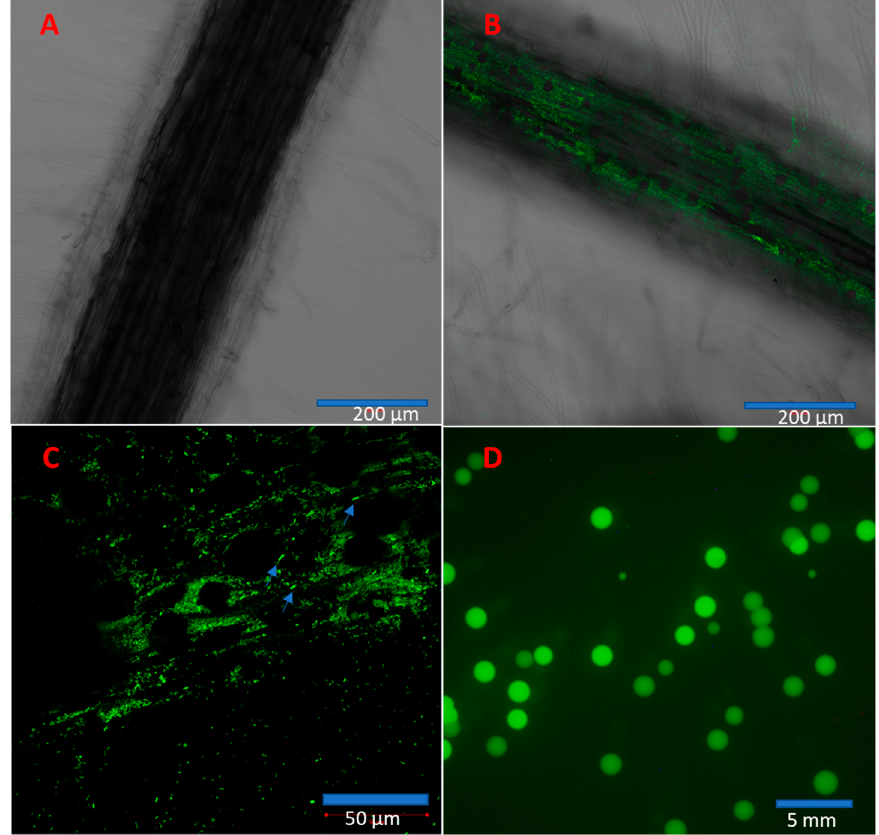
Figure 7. Colonization and translocation of IALR632-GFP in lettuce plants. ( A ) Confocal image from the control root with 10× magnification. ( B ) A confocal image of the root inoculated with IALR632- GFP showing green fluorescence with 10× magnification. ( C ) The same root shown in B with 40× magnification showing fluorescent bacteria (arrows). ( D ) Colonies of IALR632-GFP reisolated from leaves of seedlings inoculated with IALR632-GFP bacteria on plates under fluorescence microscope Olympus SZX12.